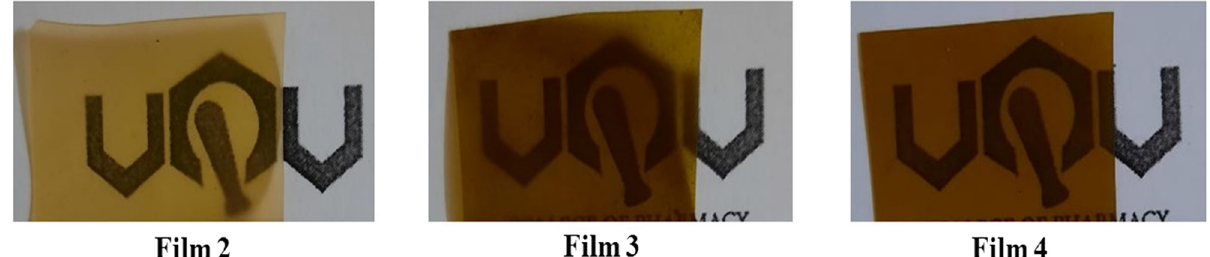
Figure 2: Di ff erent colors of CH fi